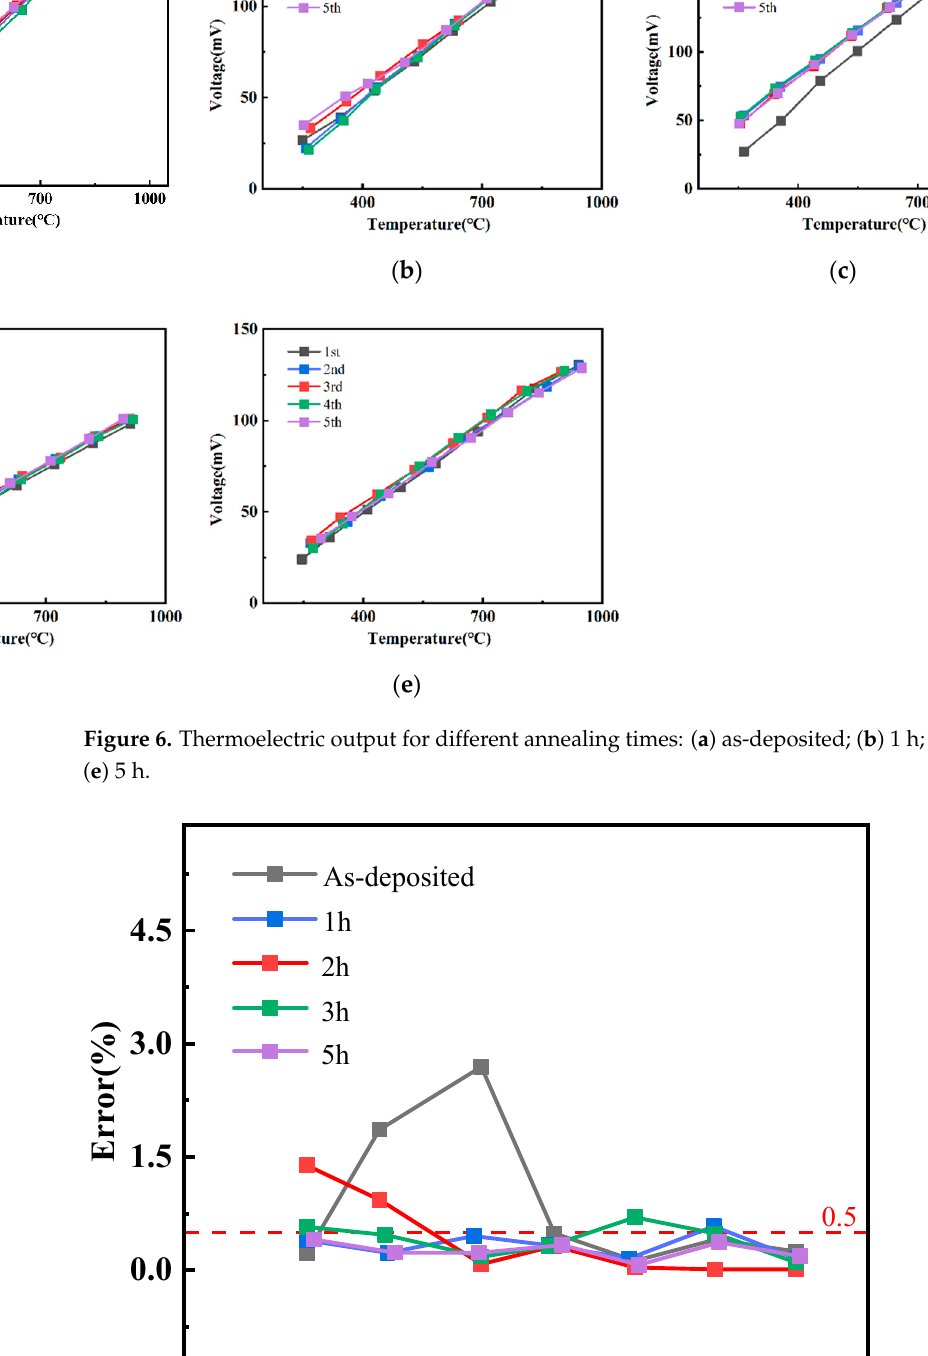
7 of 9 Figure 6. Thermoelectric output for different annealing times: ( a ) as-deposited; ( b ) 1 h; ( c ) 2 h; ( d ) 3 h; ( e ) 5 h. A third term polynomial is used to better describe the thermoelectric potential versus temperature in Equation (1): V( ∆ T) = A( ∆ T) 3 + B( ∆ T) 2 + C( ∆ T) + D, (1) the fitting results are listed in Table 2. The fitting correlation coefficients (R2) of all cali- bration curves are greater than 0.999. The coefficients of the third and second polynomials are smaller, indicating that the curve is nearly linear. According to the fitting results, the